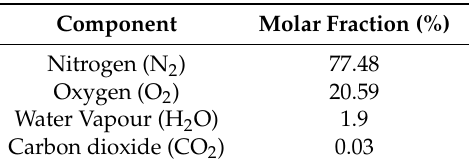
Table 2. Molar fraction of